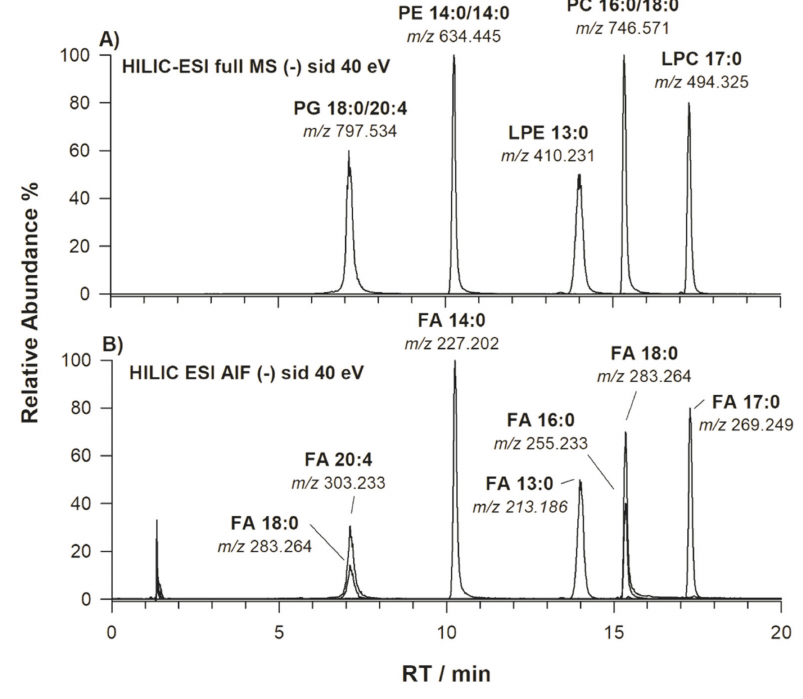
Figure 1. ( A ) Multiple extracted ion chromatogram (XIC) referred to ions at m / z 797.536 (PG 18:0 / 20:4), m / z 634.447 (PE 14:0 / 14:0), m / z 410.231 (LPE 13:0 / 0:0), m / z 746.571 (PC 16:0 / 18:0) and m / z 494.325 (LPC 17:0 / 0:0); ( B ) all ion fragmentation (AIF) multiple XIC at m / z 213.186 (FA C13:0), m / z 227.202 (FA C14:0), m / z 255.233 (FA C16:0), m / z 283.264 (FA C18:0) and m / z 303.233 (FA C20:4), obtained